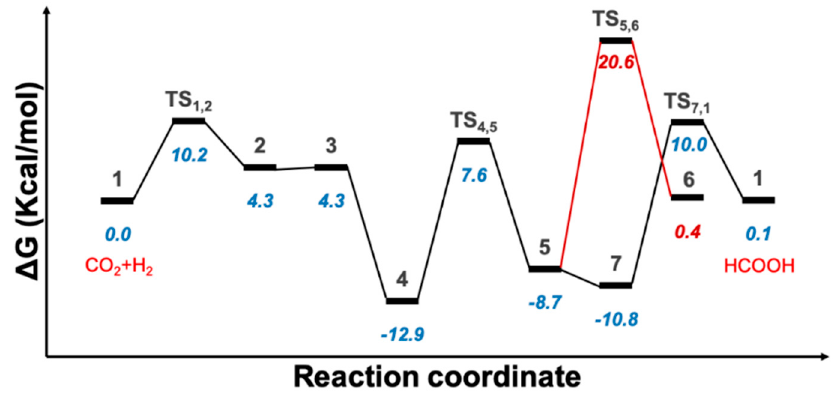
Figure 2. Free energy profile for the hydrogenation of CO 2 to formic acid catalyzed by 1 . Solvent corrected relative free energies are shown in italic with blue color.